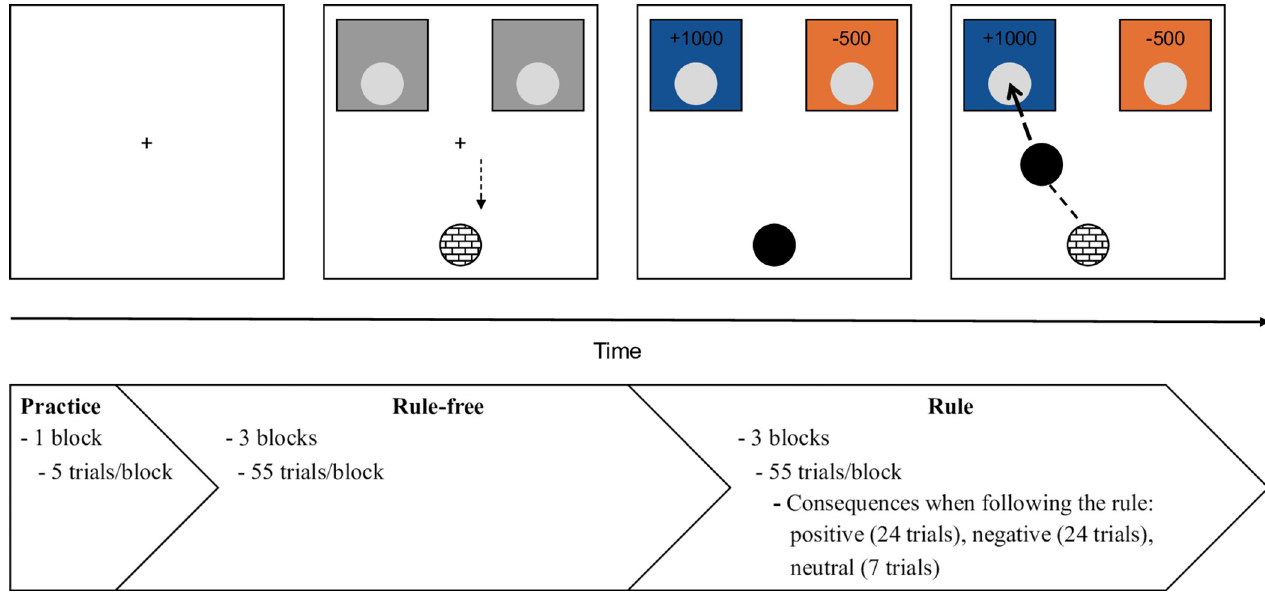
Fig 1. A. Trial structure. Following a fixation cross (500–700 ms), participants moved the mouse cursor to the home-area in the bottom-centre of the screen. Once they reached the home-area, the cursor transformed into a black ball. Simultaneously, the screen displayed the coloured boxes and the stock values for each box (the time prior to cursor pick-up while stock values were already displayed was measured as initiation time; i.e., action planning). Subsequently, participants dragged the ball from the home-area towards either of the boxes and, therewith, earned/lost the stocks associated with the chosen box (the time of the cursor movement was measured as movement time; i.e., action execution). For further information about the stimuli location on the screen see S2 File. B. Block structure. The task included a “rule-free” and a “rule” part, preceded by practice trials. After each block, participants received feedback on the total amount of stocks they accumulated. In “rule-free” blocks, participants were instructed to freely choose the number of stocks they wanted to keep for themselves. In the “rule” blocks, participants were instructed to select a specific colour, irrespective of the associated stocks. The type of consequences when following the rule in the “rule” part were fully randomised. The experiment comprised 335 trials in